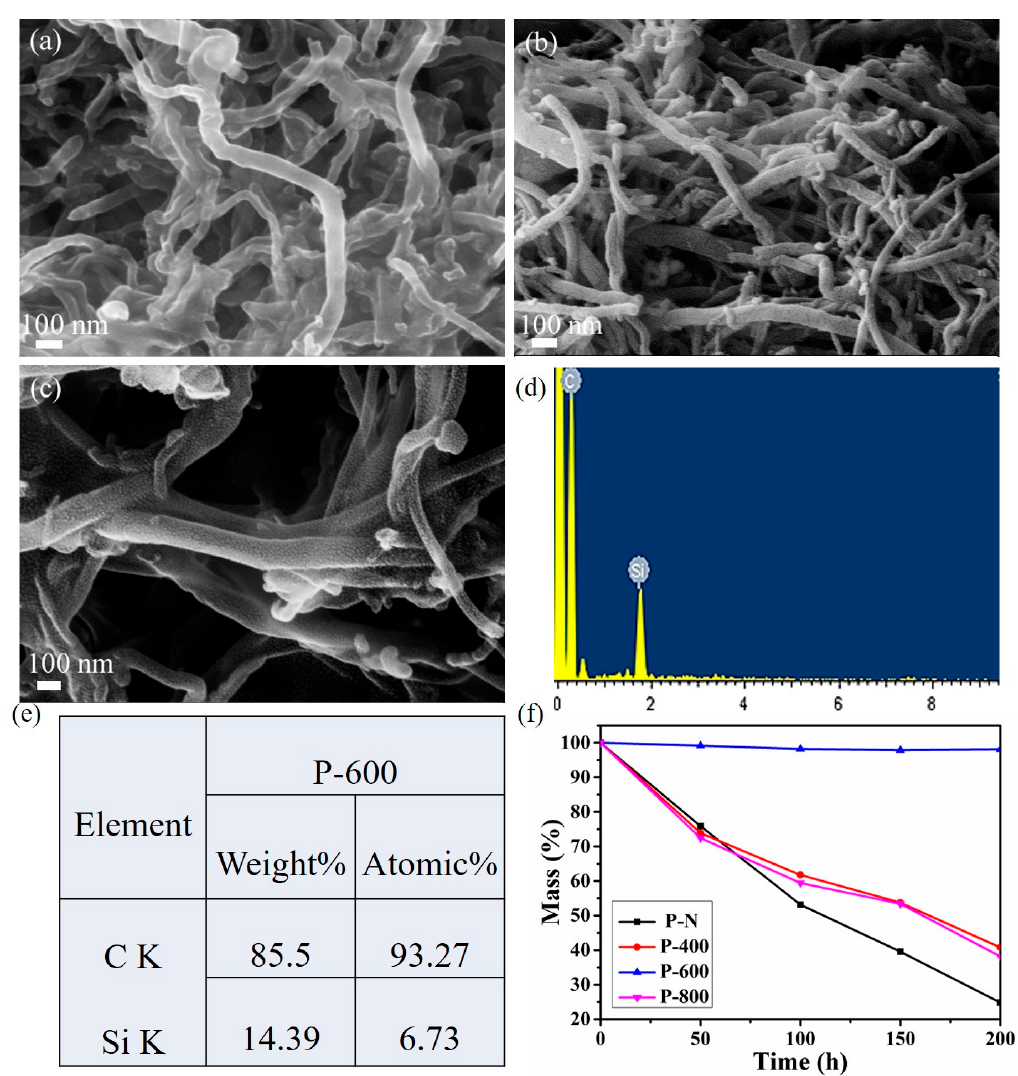
Figure 4. SEM images of PCS-coated CNTs pyrolyzed at different temperatures: ( a ) 400 °C, ( b ) 600 °C, ( c ) 800 °C, ( d , e ) EDS of CNTs/SiC, and ( f ) Mass loss of PCS coated CNTs powders pyrolyzed at different temperatures, for 0–200 h.